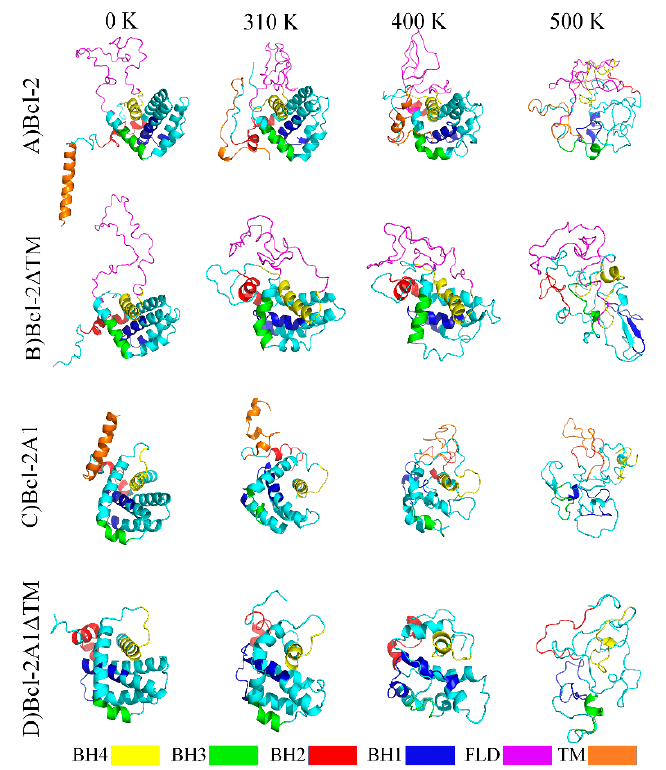
Figure 2. The middle structures obtained from the main clusters of MDS at 310, 400, and 500 K for ( A ) Bcl-2, ( B ) Bcl-2 Δ TM, ( C ) Bcl-2A1, and ( D ) Bcl-2A1 Δ TM. Domains are colored as indicated.